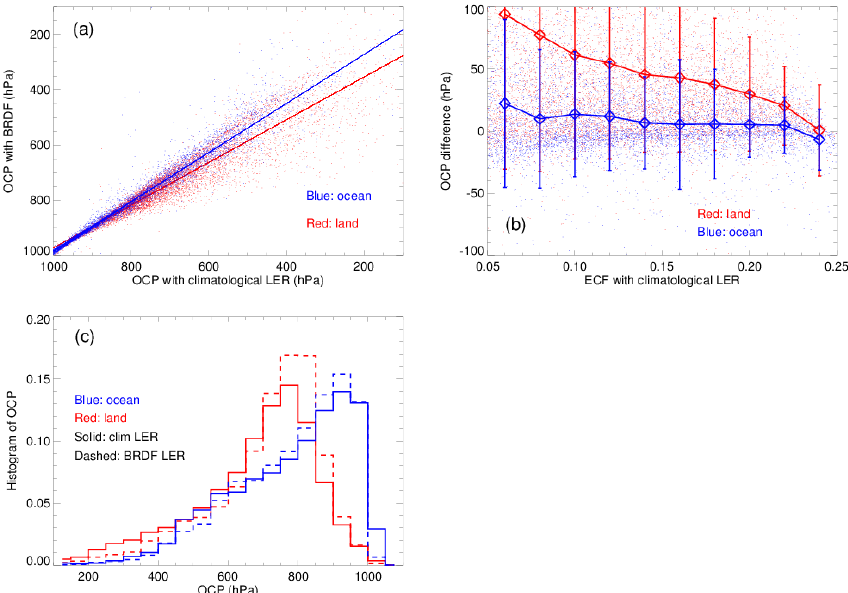
Figure 10. (a) Scatter plot of O 2 –O 2 -retrieved OCPs computed with geometry-dependent LERs vs. climatological LERs with linear fits; data are for 0 . 05 < ECF < 0 . 25. (b) The mean ECF difference (diamonds) and standard deviation (error bars) as a function of ECF. (c) Normalized histograms of